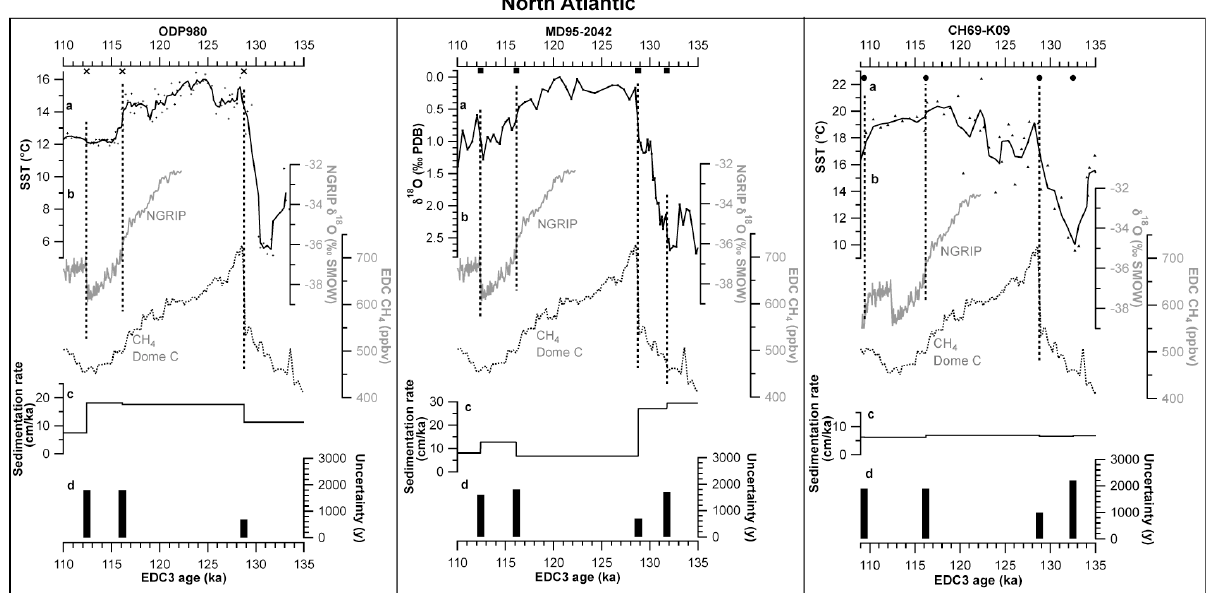
Fig. 5. Definition of the age model of the three sediment cores from the North Atlantic. (a) (left panel) Sea surface temperature (3-point smoothing curve, black line) from core ODP 980 (Oppo et al., 2006); (mid panel) planktic δ 18 O record (black line) from core MD95-2042 (Shackleton et al., 2002); (right panel) Sea surface temperature (3-point smoothing curve, black line) from core CH69-K09 (Cortijo et al., 1999). (b) (all panels) Greenland NGRIP ice δ 18 O record (North Greenland Ice Core Project members, 2004) (grey line) and Antarctic EDC methane record (Loulergue et al., 2008) (grey dotted line). (c) (all panels) Sedimentation rate variations. (d) (all panels) Age uncertainty of the defined tie-points (see Table 4 for details). Tie-points are indicated by symbols (crosses for core ODP 980, left panel; squares for core MD95-2042, mid panel; circles for core CH69-K09, right panel) and highlighted by the vertical dotted lines.